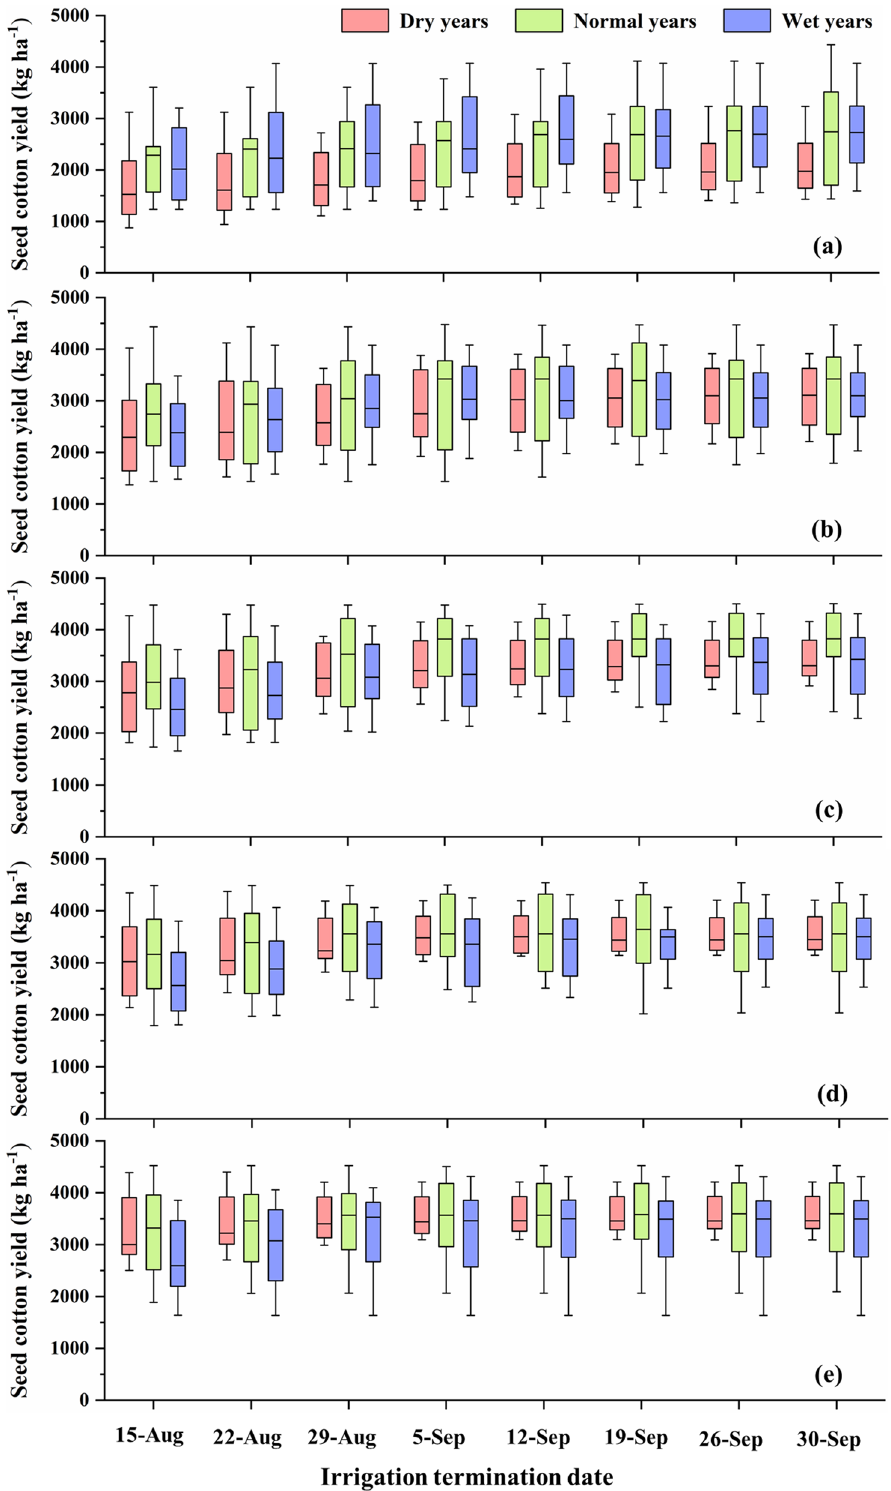
Figure 2. Effect of irrigation termination date on simulated seed cotton yield under: ( a ) 55%, ( b ) 70%, ( c ) 85%, ( d ) 100%, and ( e ) 115% ET-replacement strategies. The ends of the boxes indicate 25th and 75th percentiles, and the horizontal line inside the box indicates the